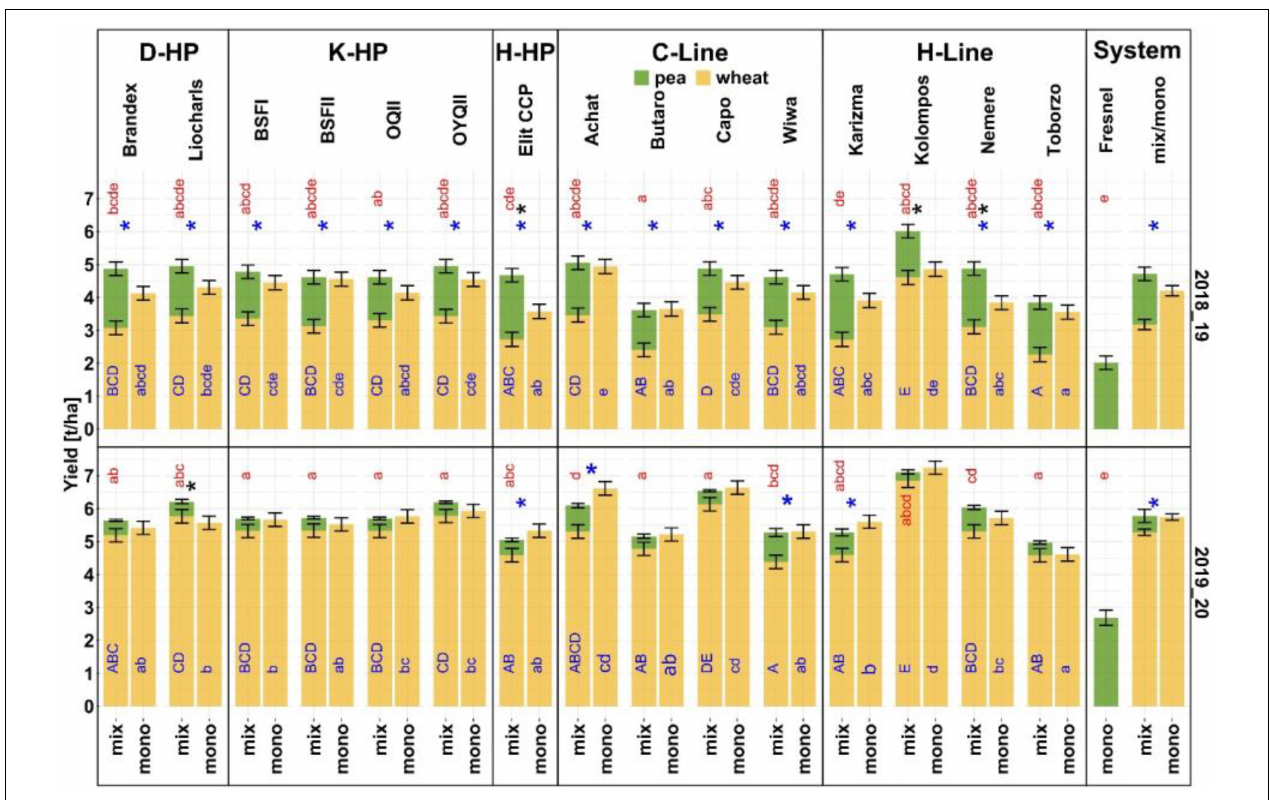
FIGURE 4 | Yield in the mixtures and monocultures (2018/19 and 2019/20). Estimated marginal means and standard error from linear mixed effect models are plotted. Significant differences at P < 0.05 estimated from mixed models with pairwise comparison and Holm correction are shown. Small blue letters indicate significant differences among wheat entries in the monocultures and blue capital letters among the wheat cultivar mixtures. Red letters indicate significant differences in pea yield. Asterisks indicate significant differences in wheat yield (blue) and total yield (wheat + pea) (black) between